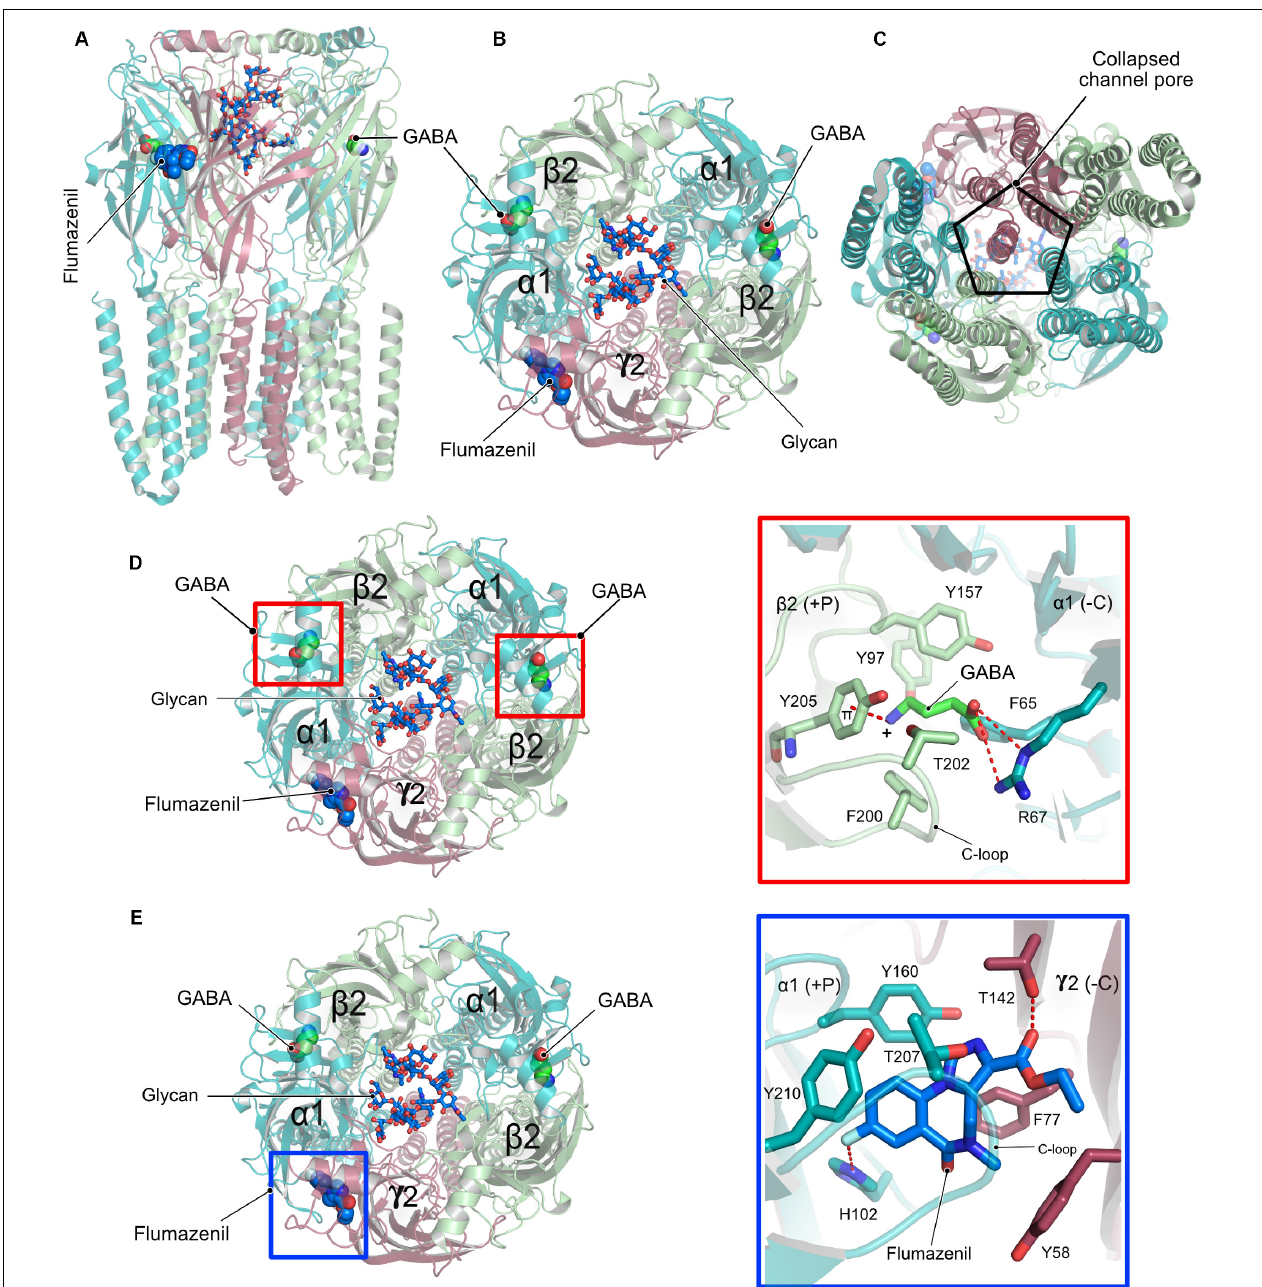
FIGURE 5 | Structure and organization of a heteropentameric GABA A R. (A) Side view of the cryo-EM structure of the α 1 β 2 γ 2 heteropentamer in complex with GABA and flumazenil shown in space-filling representation and with their C-atoms colored in green and blue, respectively. (B) View of the receptor from the ECD with the N-linked glycans (stick representation) of the α 1-subunits pointing into the extracellular vestibule. (C) View of the receptor from the intracellular side clearly demonstrating how the γ 2 subunit breaks the fivefold symmetry and obstructs the pore of the receptor. (D) Close-up view of the neurotransmitter binding pocket displaying the interaction of GABA and the β 2- α 1 receptor subunits. (E) Zoom into the benzodiazepam binding pocket displaying how flumazenil is bound at the α 1- γ 2